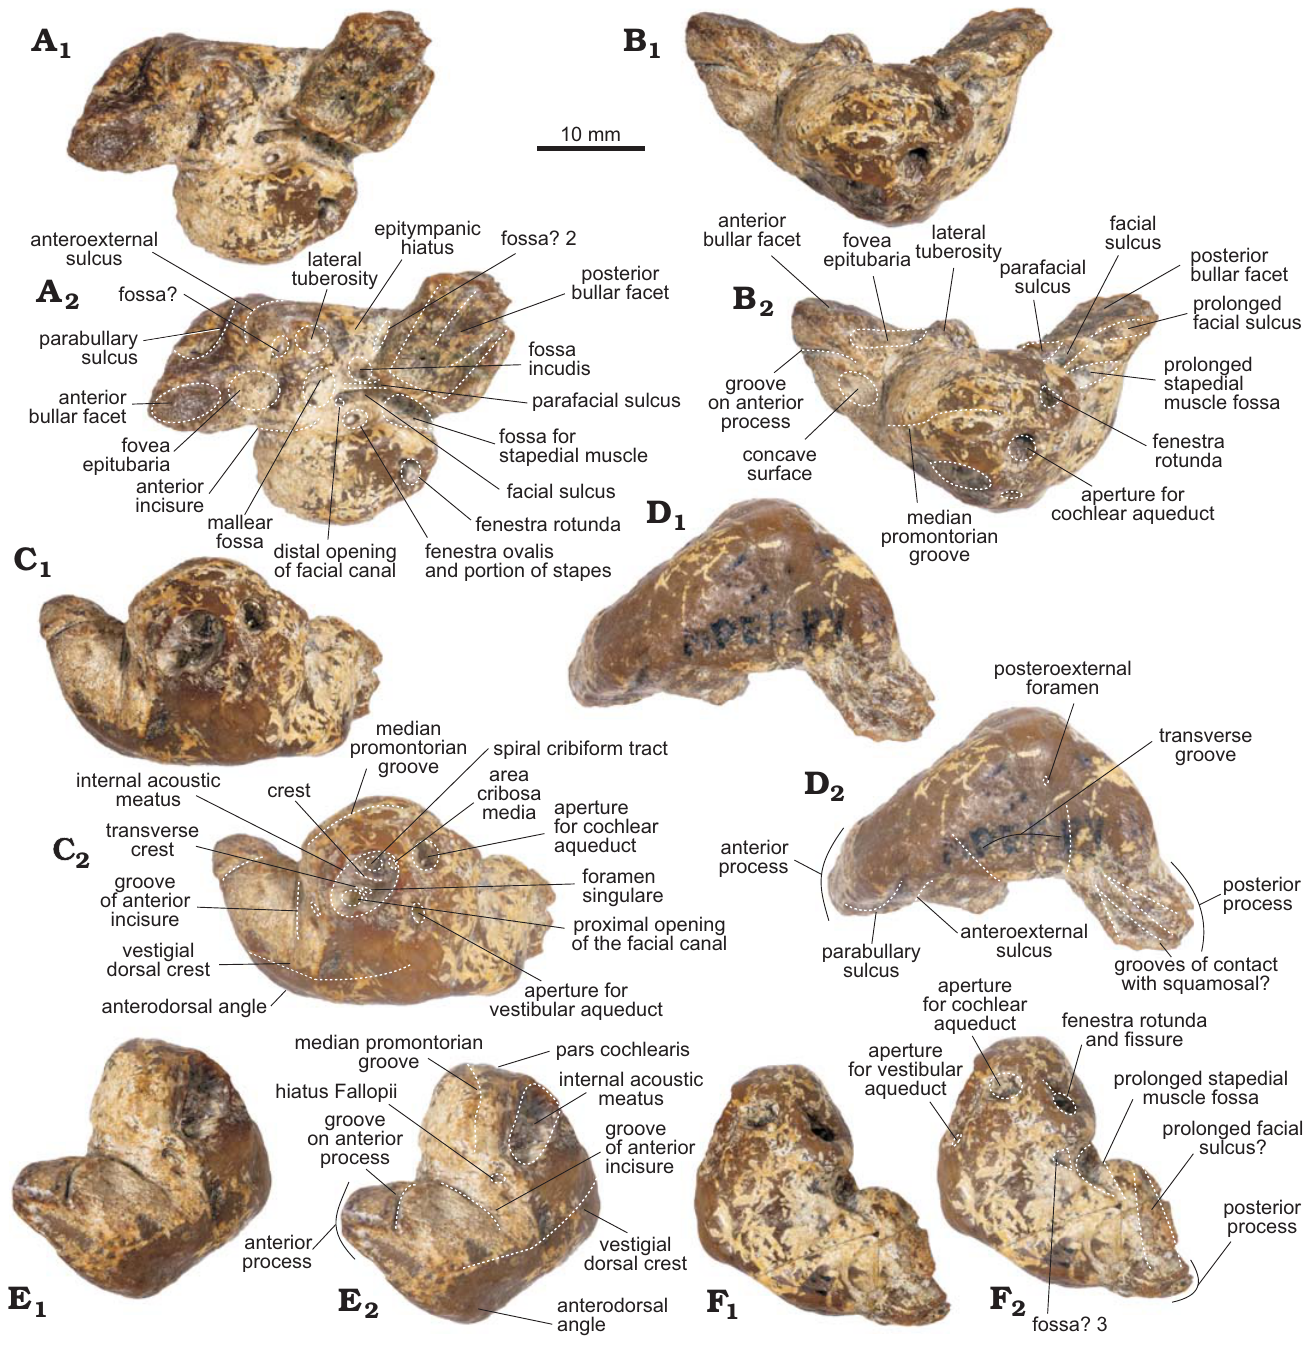
Fig. 5. Left periotic of the holotype of the platanistoid dolphin Aondelphis talen gen. et sp. nov. (MPEF-PV 517) from the early Miocene Gaiman Formation, Bryn Gwyn, Patagonia, Argentina; in ventral ( A ), medial ( B ), dorsal ( C ), lateral ( D ), anterior ( E ), and posterior ( F ) views. Dashed lines indi- cate specific structures. Photographs (A 1 –F 1 ), photographs with explanations (A 2 –F 2